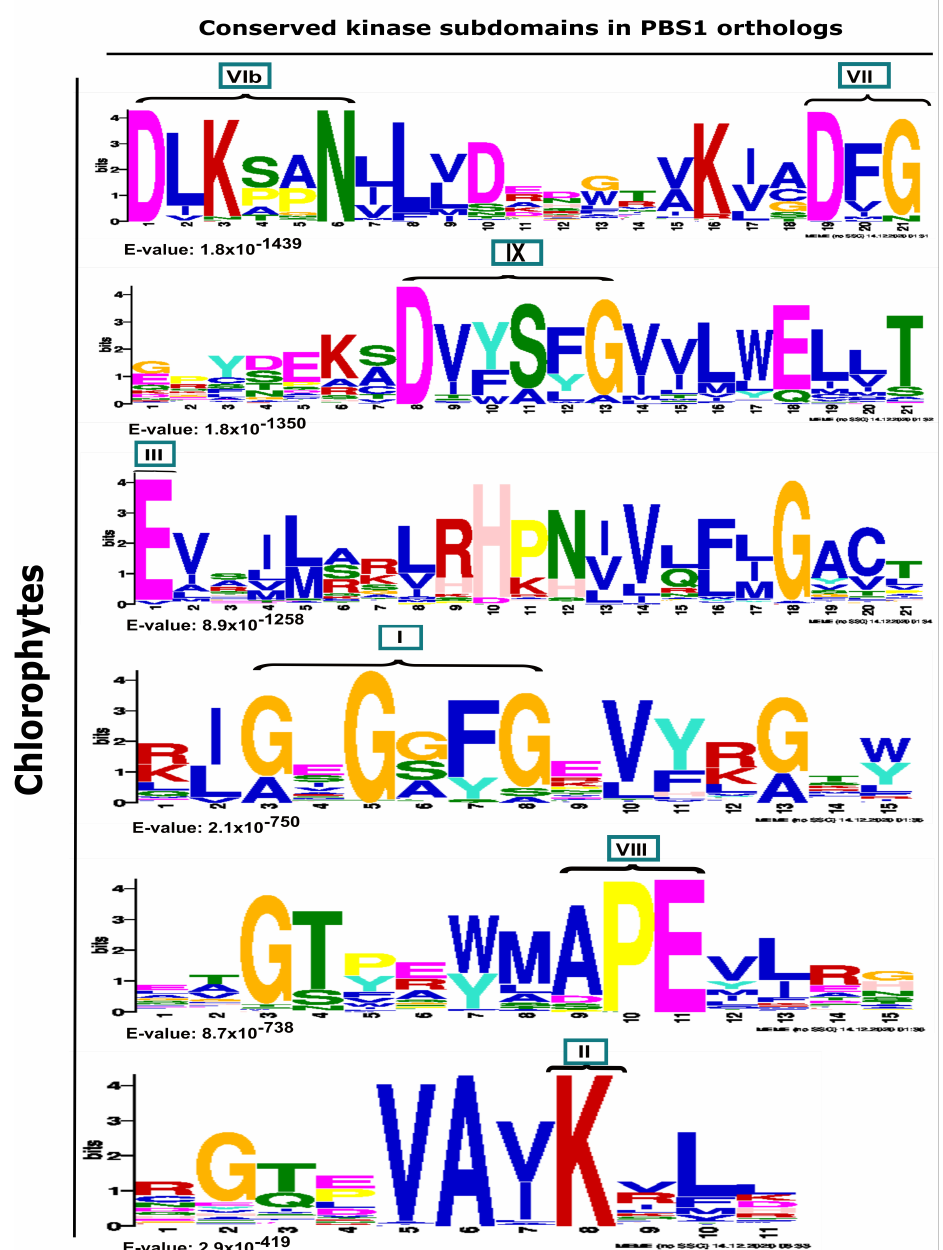
Figure 2. Analysis of conserved kinase subdomains in PBS1 orthologs in chlorophytes. Sequence logo representation of multiple sequence alignment of 116 sequences from chlorophytes with high similarity to Arabidopsis PBS1 were identified by MEME analysis. The domains are ordered from lowest to the highest expectation (E) values. The conserved kinase subdomains are labeled with Roman numerals. Subdomain I: GxGxxG; II: K; III: E; VIb: DxxxxN; VII: DFG; VIII: APE; IX:DxxxxG; XI: R. PBS1 orthologs in chlorophytes do not contain the GDK cleavage site and the recognition motif required for RPS5-mediated plant